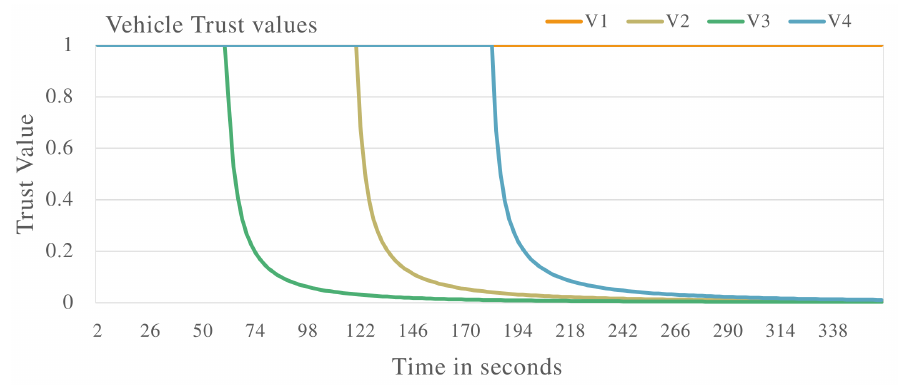
Figure 2. Vehicle trust values with malicious vehicles present that are dropping messages in the VANET.